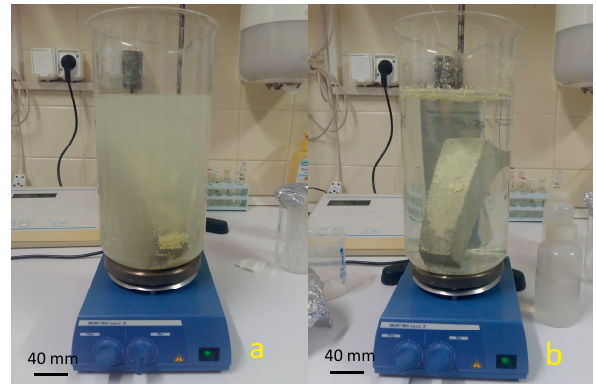
Figure 1. Mortar specimens in bacterial ( a ) and non-bacterial ( b ) medium.